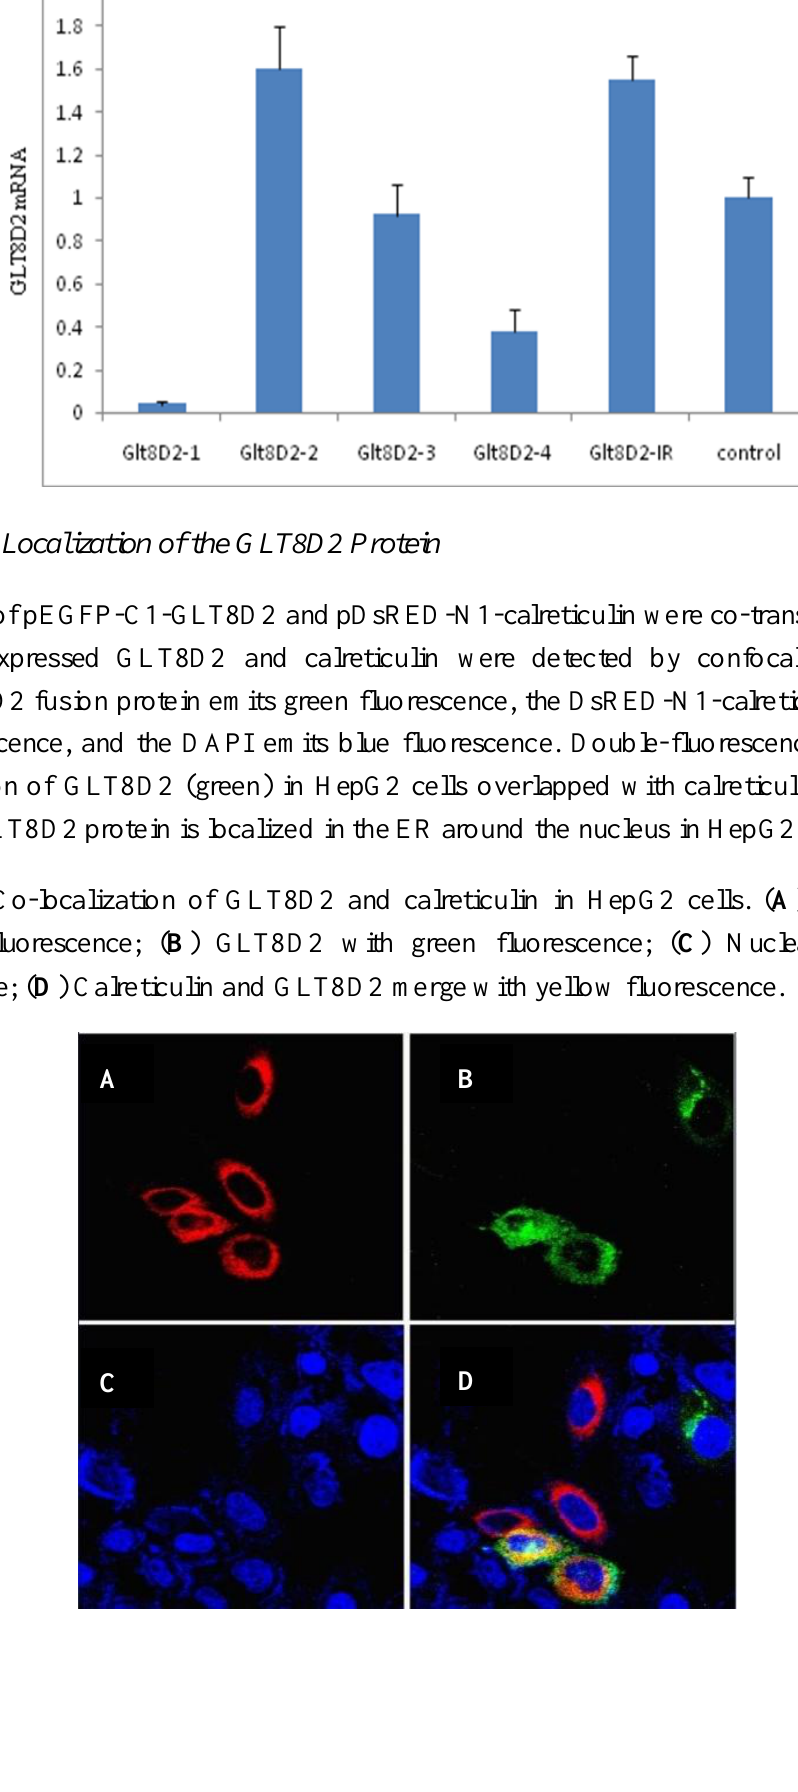
Figure 3. Knockdown efficiency of GLT8D2 shRNAs in HepG2 cells revealed by qRT-PCR.